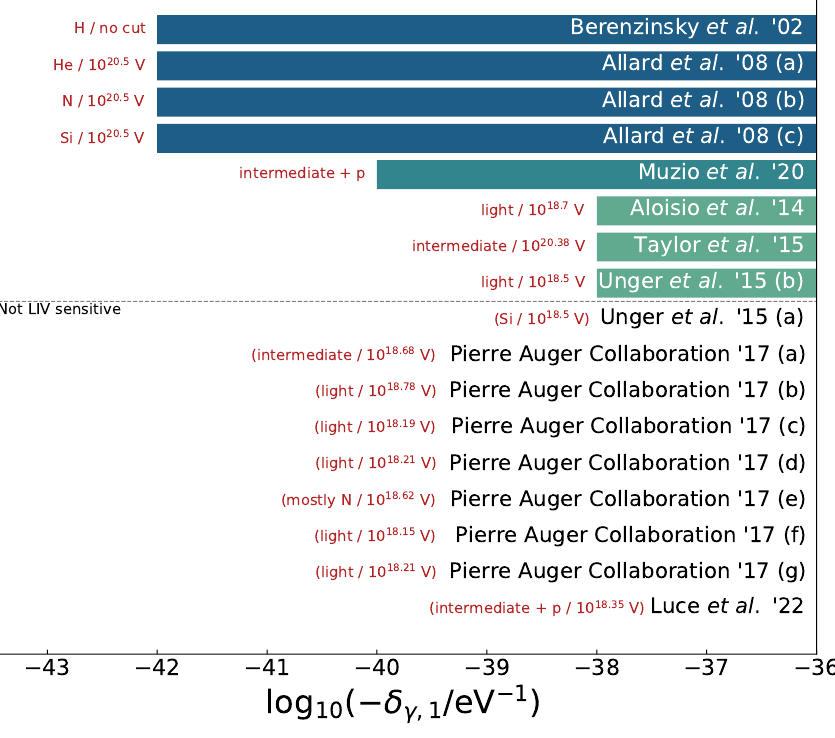
Figure 5. Same as Figure 4, but for n =